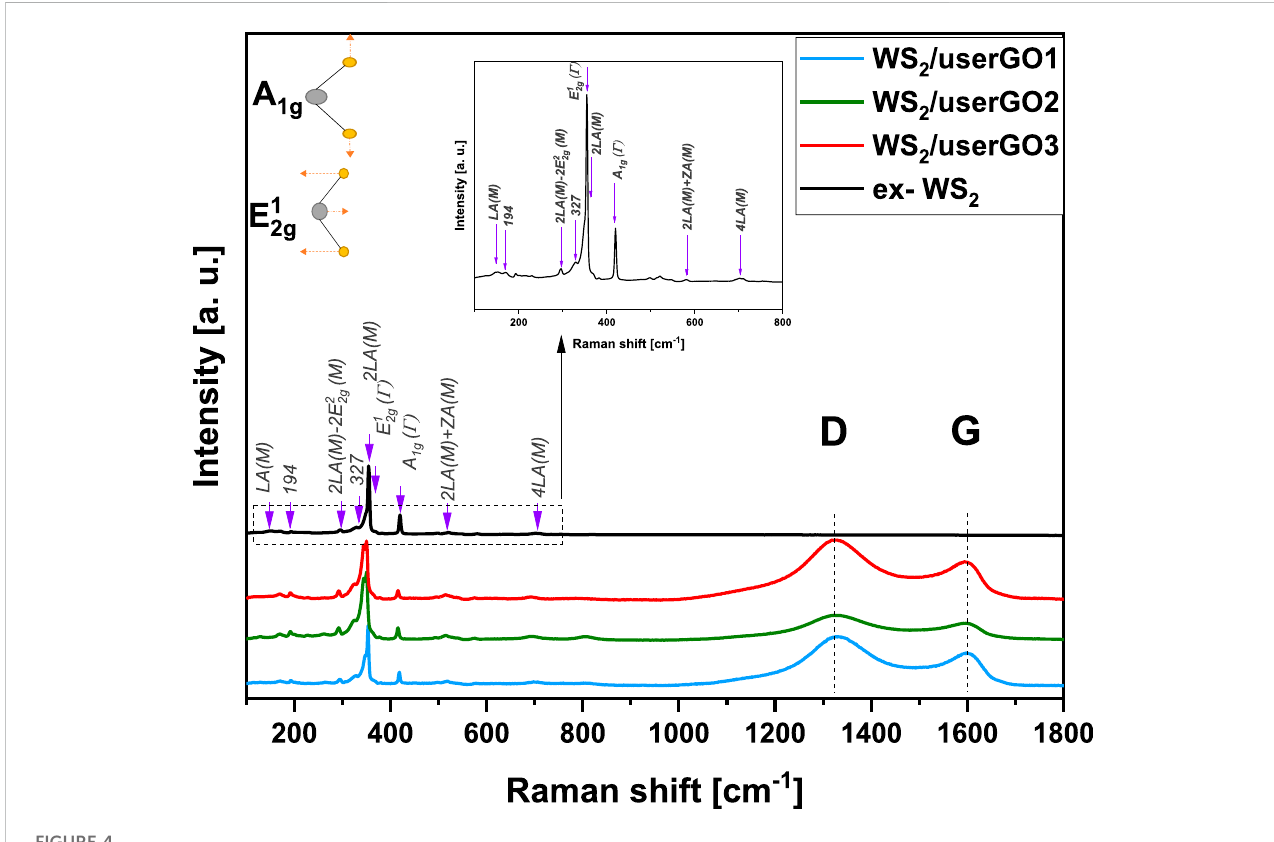
FIGURE 4 Raman spectroscopy of WS 2 /userGO1, WS 2 /userGO2, WS 2 /userGO3 fi lm, and ex- WS 2.